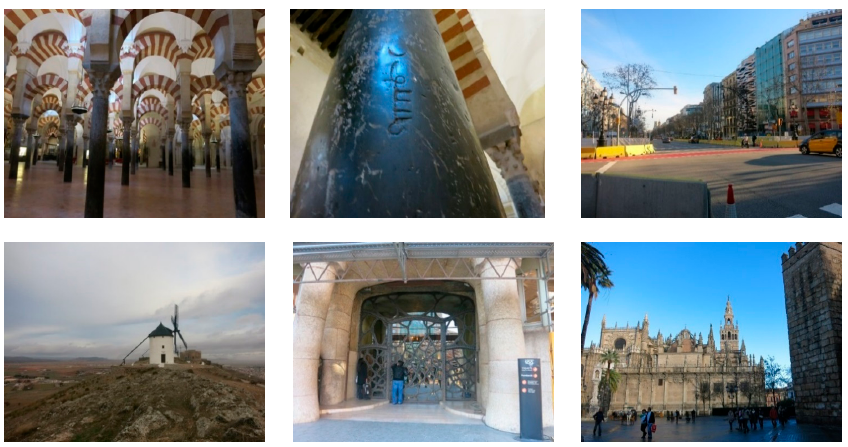
Figure 5. Examples of images containing speed-limit signs (positive images) in a variety of conditions.